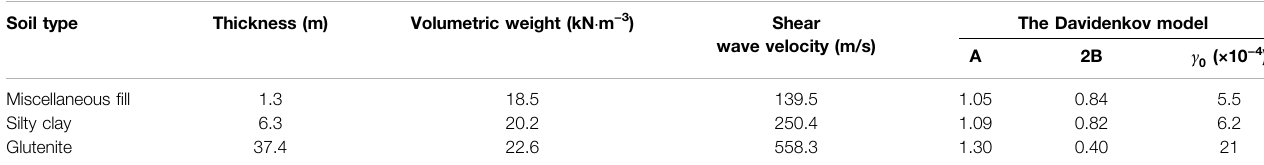
TABLE 2 | Soil pro fi le and parameters of the Davidenkov model.